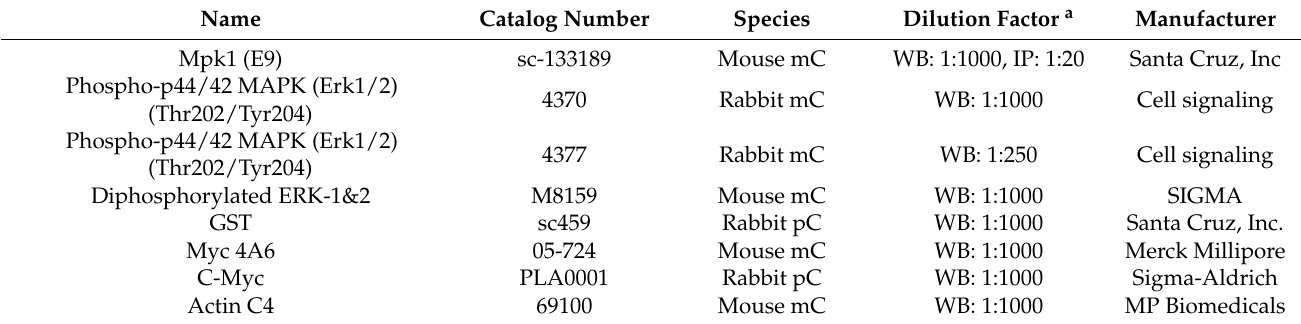
Table 3. Primary antibodies used in this